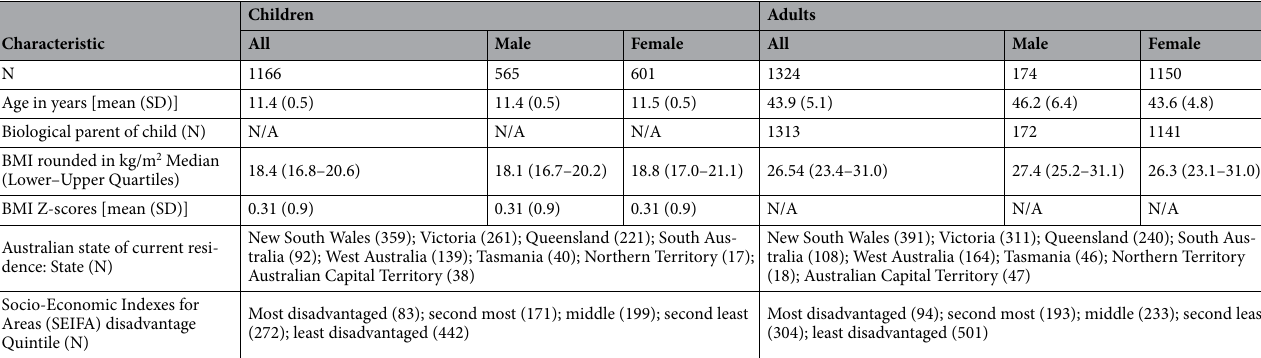
Table 1. Sample characteristics. Skewed variables were reported as medians and lower/upper quartiles, and normally distributed variables as means and standard